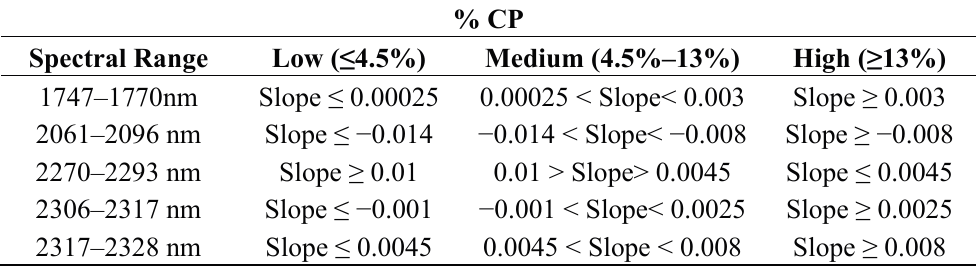
Table 3. Slope-based criteria for assessment of pasture quality using three levels of CP, NDF and MEC, after resampling the spectral region of FOS-5000 (700 bands at 1100–2363 to spectral region of advanced imaging spectrometer for applications (AISA) (109 bands at 970–2500